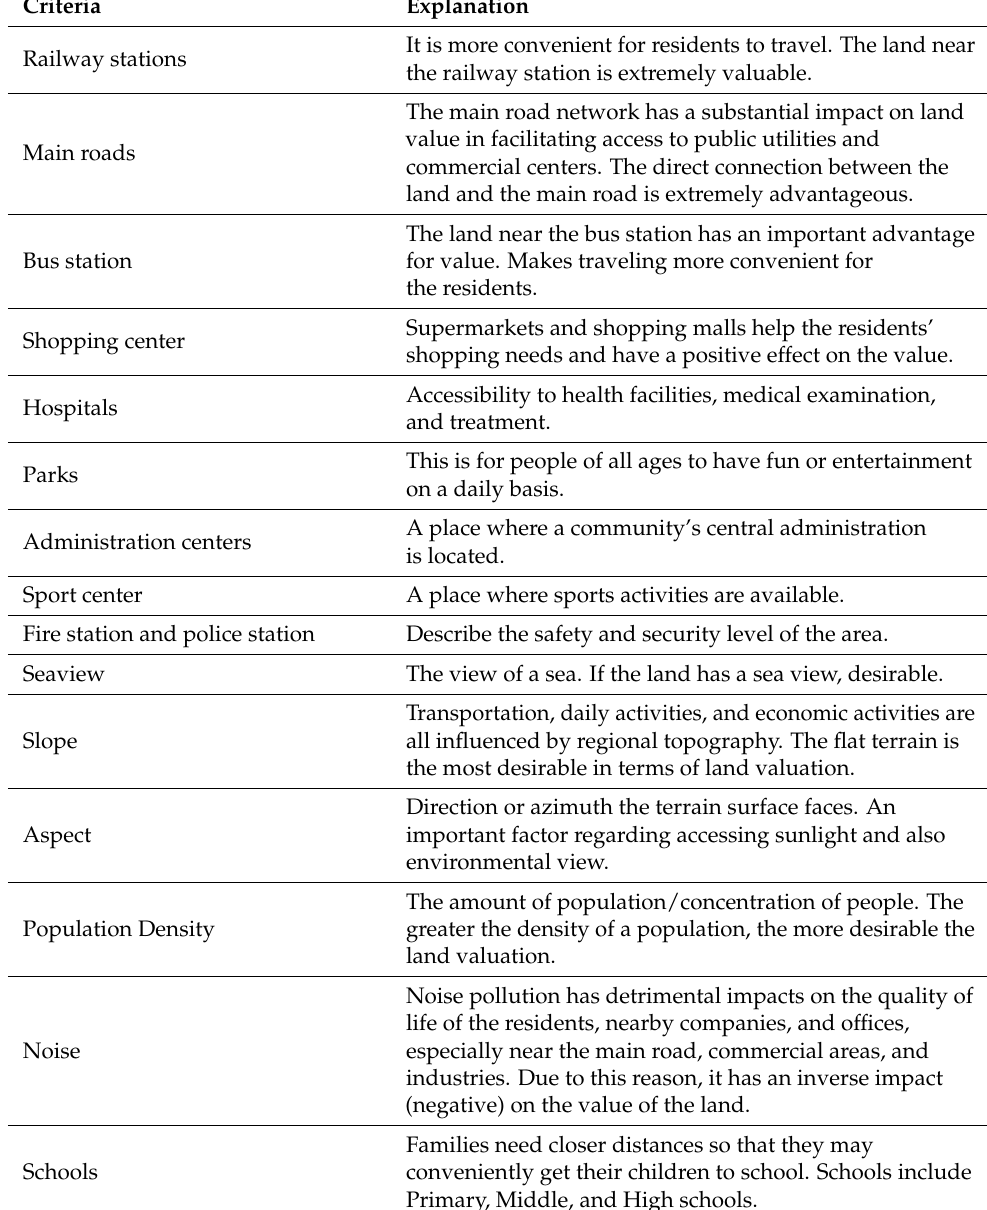
Table 3. Explanation of criteria used in this